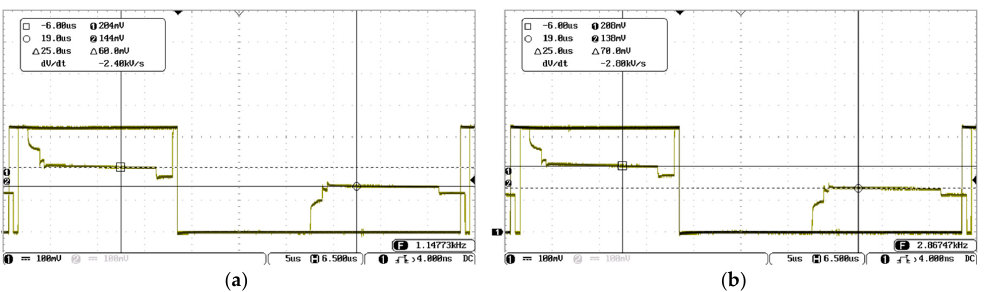
Figure A4. ( a ) “Released” signal; and ( b ) “pressed” signal.